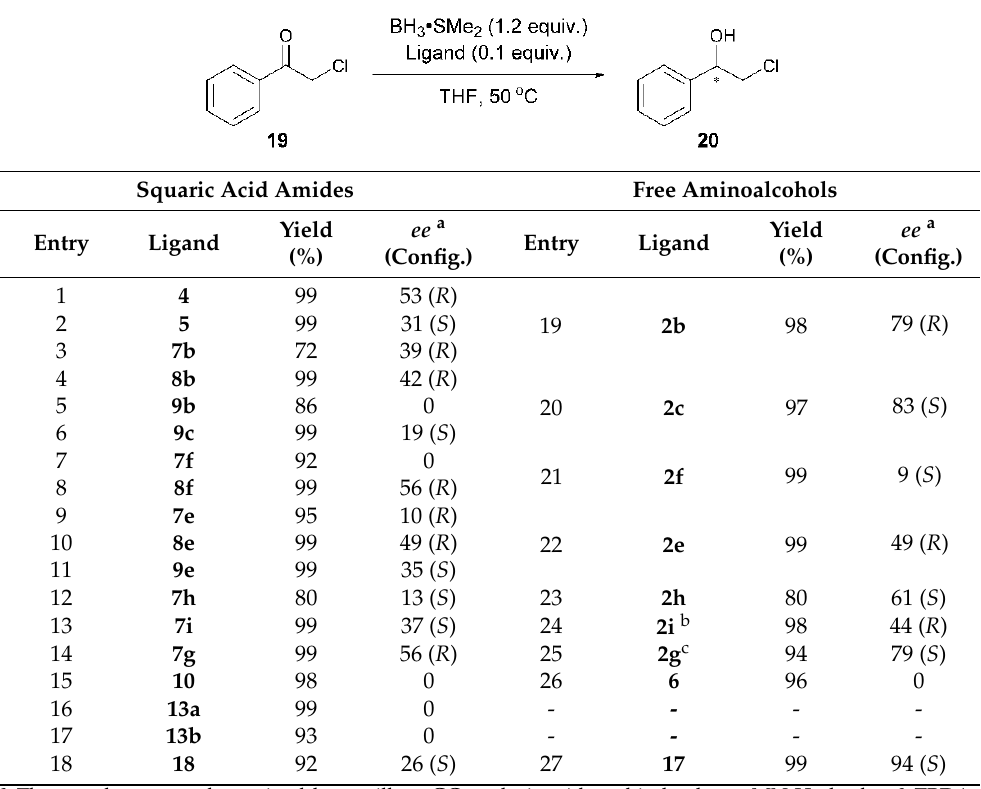
Table 1. Catalytic asymmetric borane reduction of α -chloroacetophenone by applying chiral squaric acid amides and aminoalcohols as ligands.